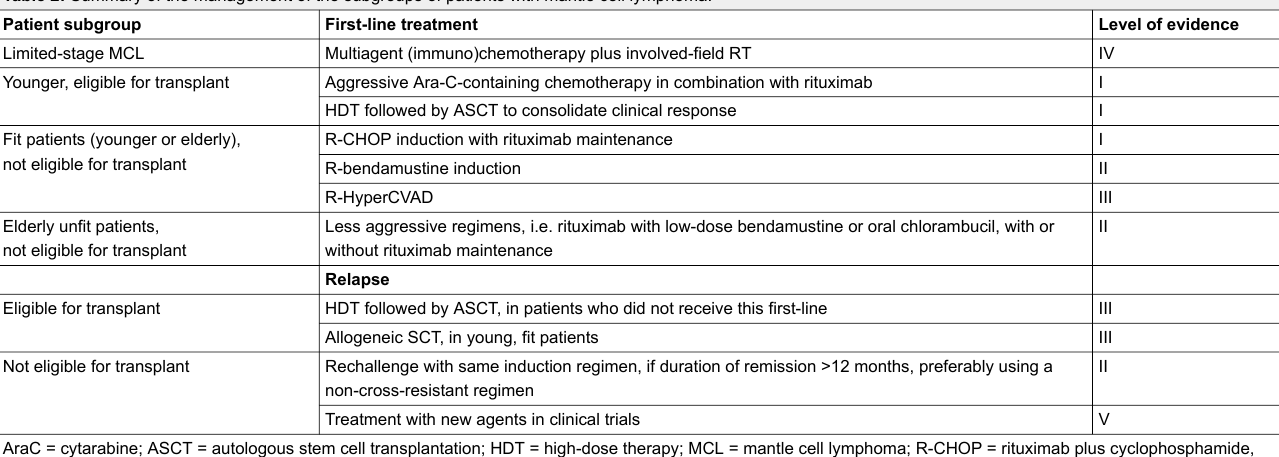
Table 2: Summary of the management of the subgroups of patients with mantle cell lymphoma. Patient